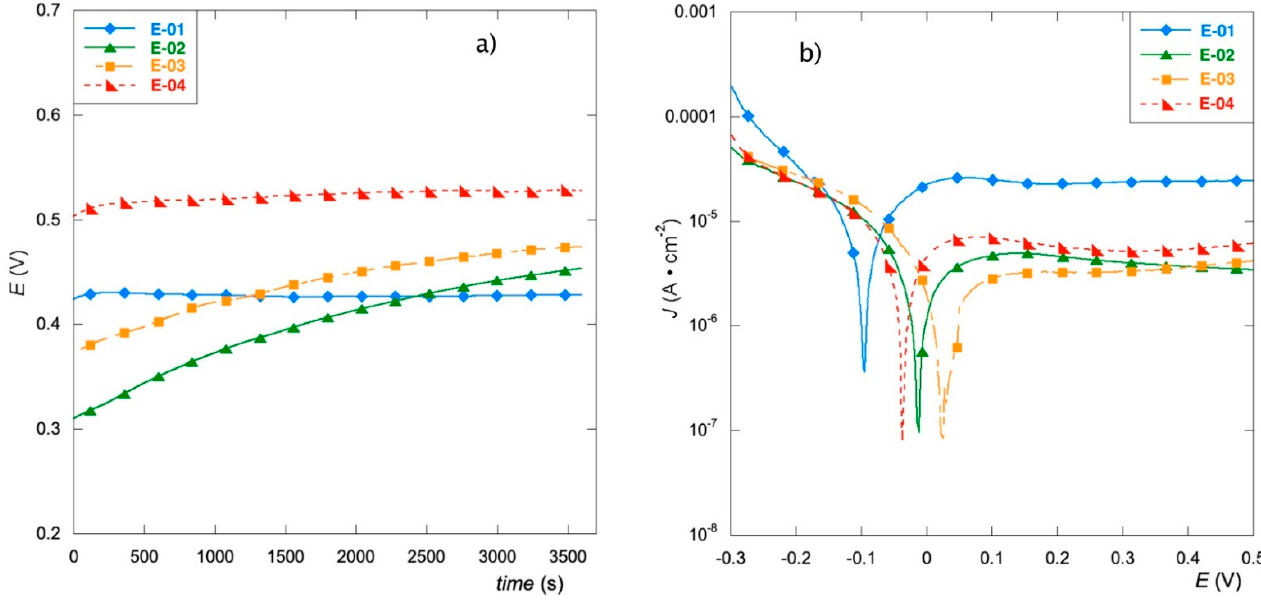
Figure 2. OCP values ( a ) and polarization curves ( b ) of the prepared materials in Na 2 SO 4 0.1 mol L − 1 solution.